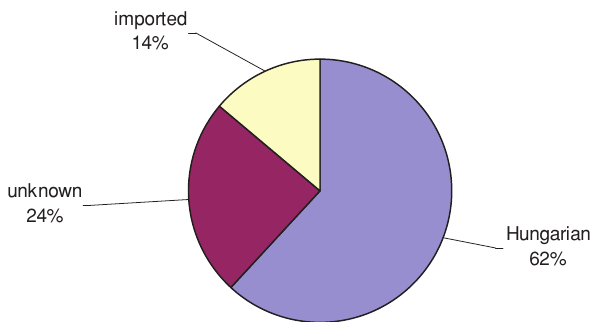
Figure 1. Distribution of the fruits of different origin in the department stores